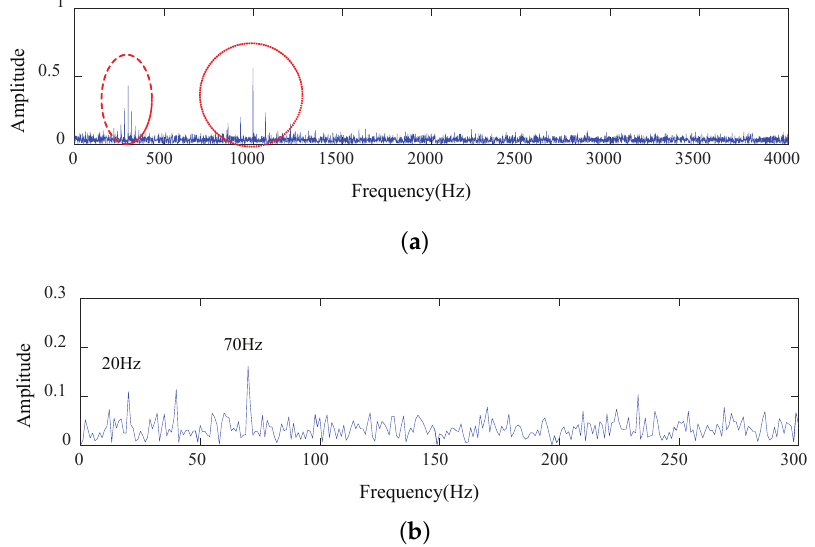
Figure 5. Frequency spectrum and envelope spectrum of the simulated signal: ( a ) Frequency spectrum of the simulated signal. ( b ) Envelope spectrum of the simulated signal.